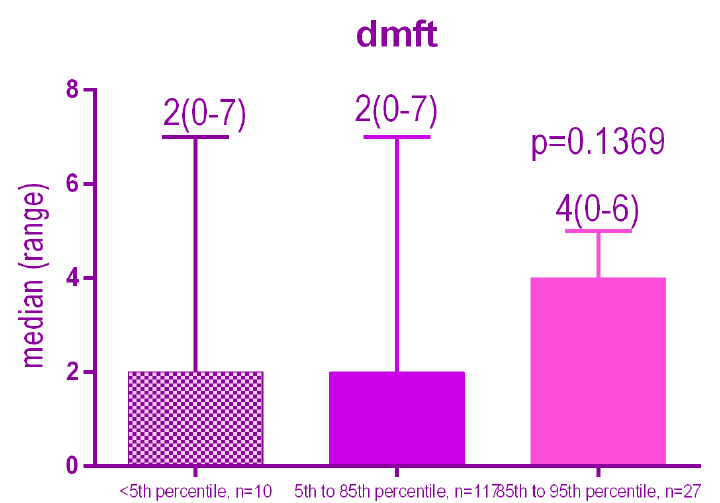
Figure 3. Distribution of the dmft index according to the BMI. There was a weak but statistically significant negative relationship ( r = − 0.31, p < 0.0001) between dmft and the frequency of toothbrushing. The more frequent the toothbrushing, the lower the dmft (Figure 4).